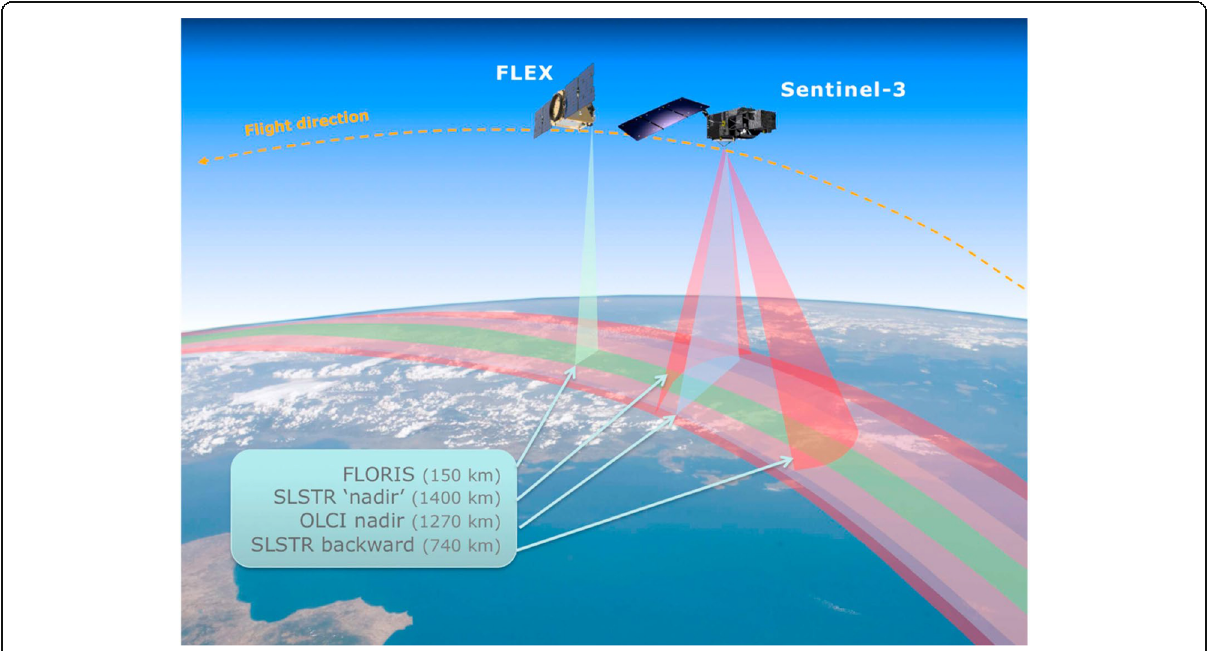
Fig. 12 The FLEX Earth Explorer 8 mission consists of a fluorescence instrument, FLORIS, and Sentinel-3C. FLEX will fly ahead of S-3, overlapping swaths of OLCI and SLSTR instruments. (from https://directory.eoportal.org/web/eoportal/satellite-missions/f/flex. Accessed